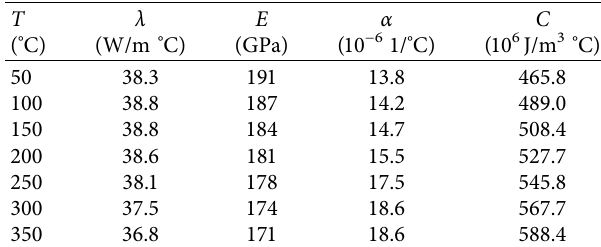
Figure 4: (a) FE global model of the RPV with applied boundary conditions, thermal, and pressure loadings and (b) RPV submodel. Table 2: Thermomechanical properties of the RPV steel